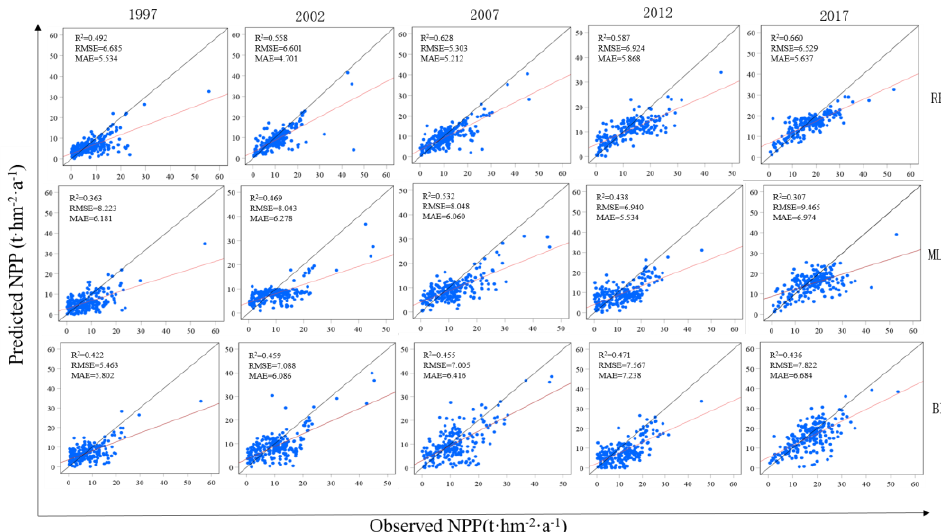
Figure 2. The performance of different inversion models in different years.